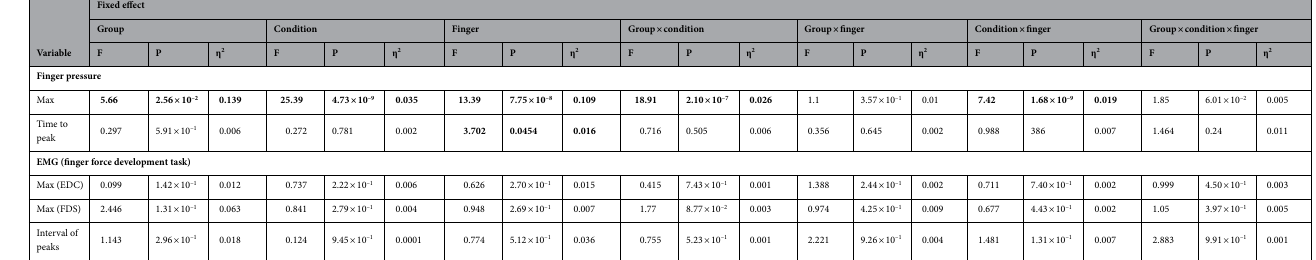
Table 2. Results of two-way mixed-design ANOVA for each of the finger pressure and activations of the EDC (extensor) and FDS (flexor) muscles in the finger force production task. Significant values are in bold.